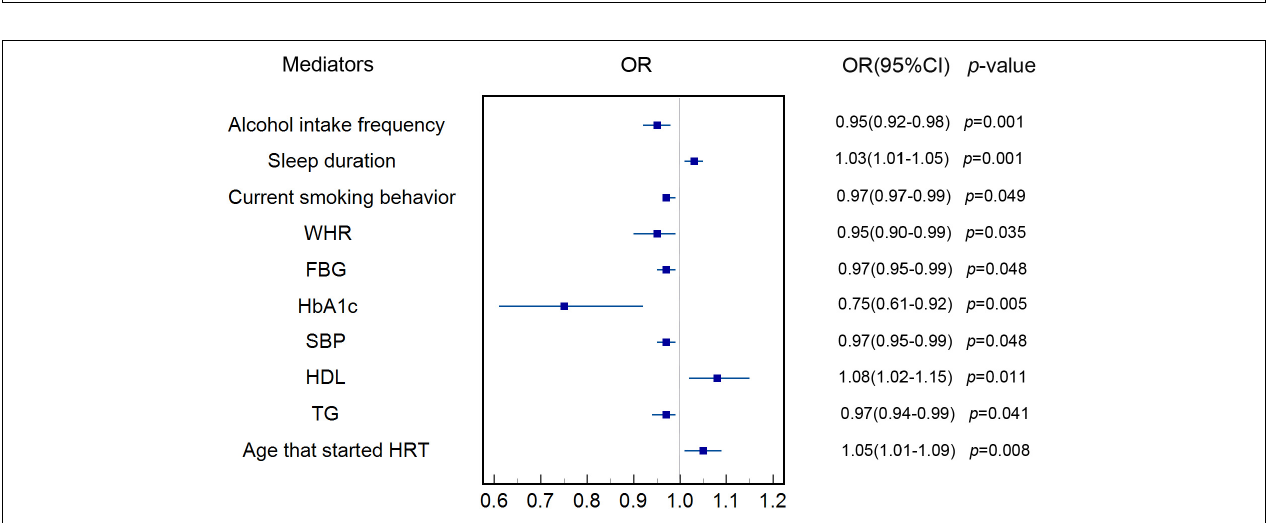
FIGURE 1 | Estimate of associations of genetically predicted AAM with genetically predicted MI. IVW was applied as main analysis for estimating the association of genetically predicted AAM with genetically predicted MI. AAM, age at menarche; MI, myocardial infarction; IVW, inverse variance weighted.